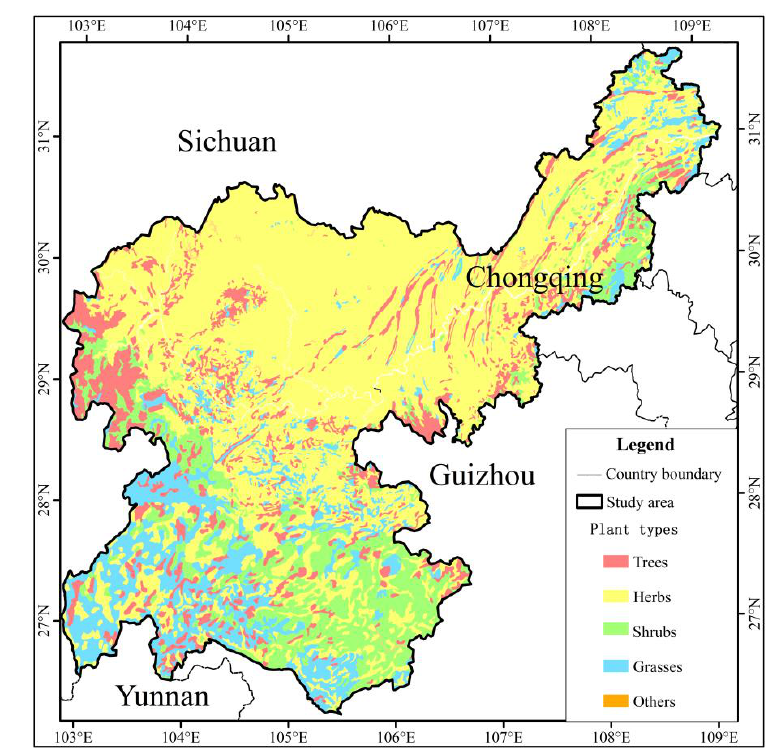
Figure 4. Map of main plant types distribution. Int. J. Environ. Res. Public Health 2018 , 15 , x FOR PEER REVIEW